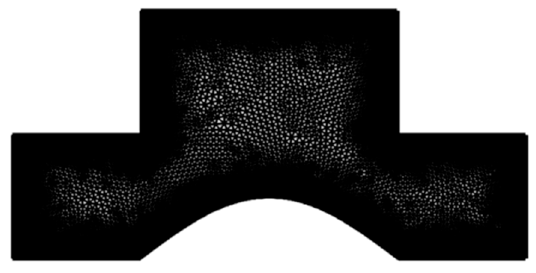
Figure 2. Mesh of the model.